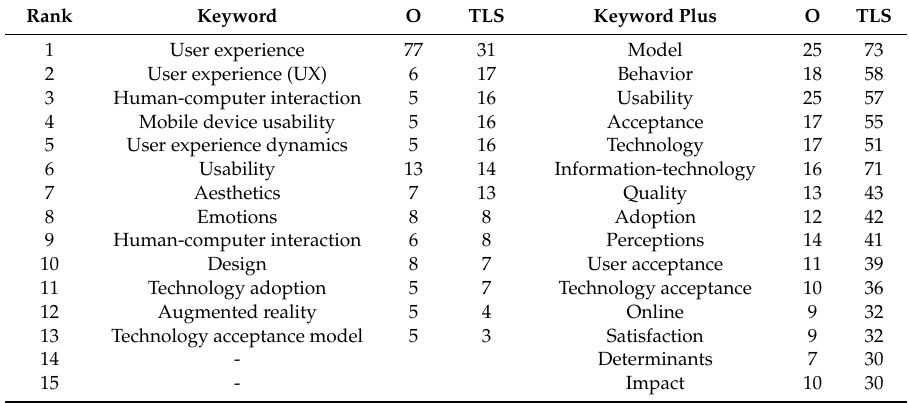
Table 6. Keywords and keywords plus. Source: Own elaboration based on VOSviewer.